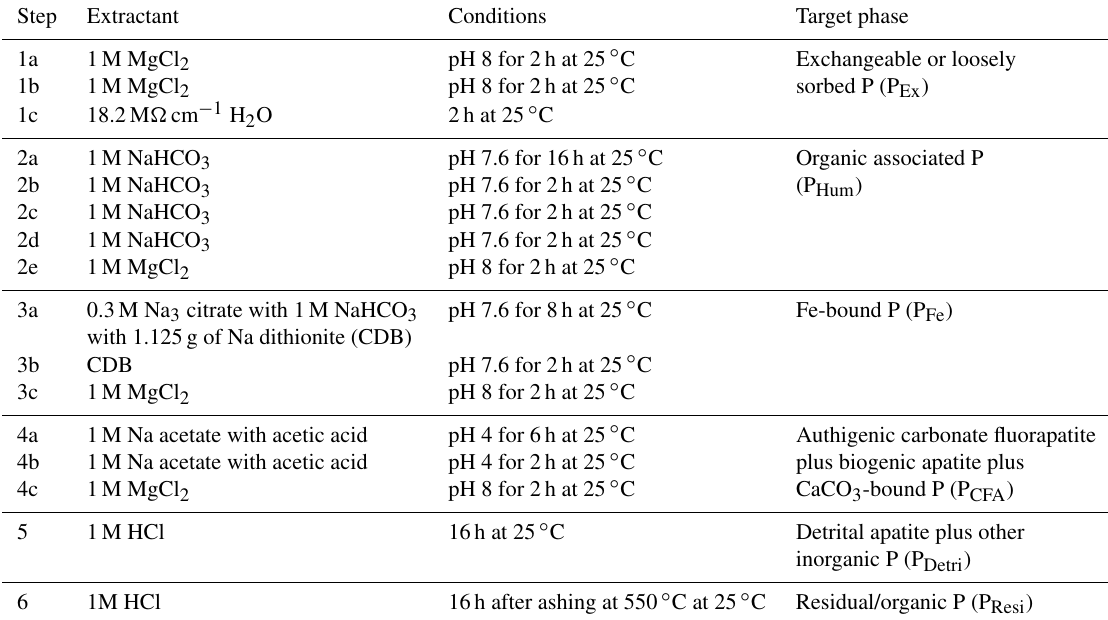
Table 1. Summary of the modified SEDEX sequential extraction protocol used on solid samples taken over a time series during the reactor experiment. Results of this extraction are shown in Fig.